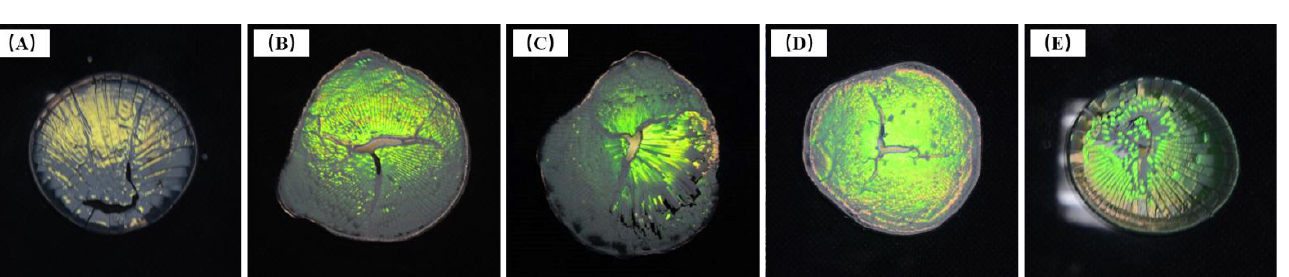
Figure 3. Photos of dried test samples of P(St-AA) colloidal microspheres synthesized with different emulsion polymerization times: ( A ) 6 h; ( B ) 8 h; ( C ) 10 h; ( D ) 12 h; ( E ) 14 h.